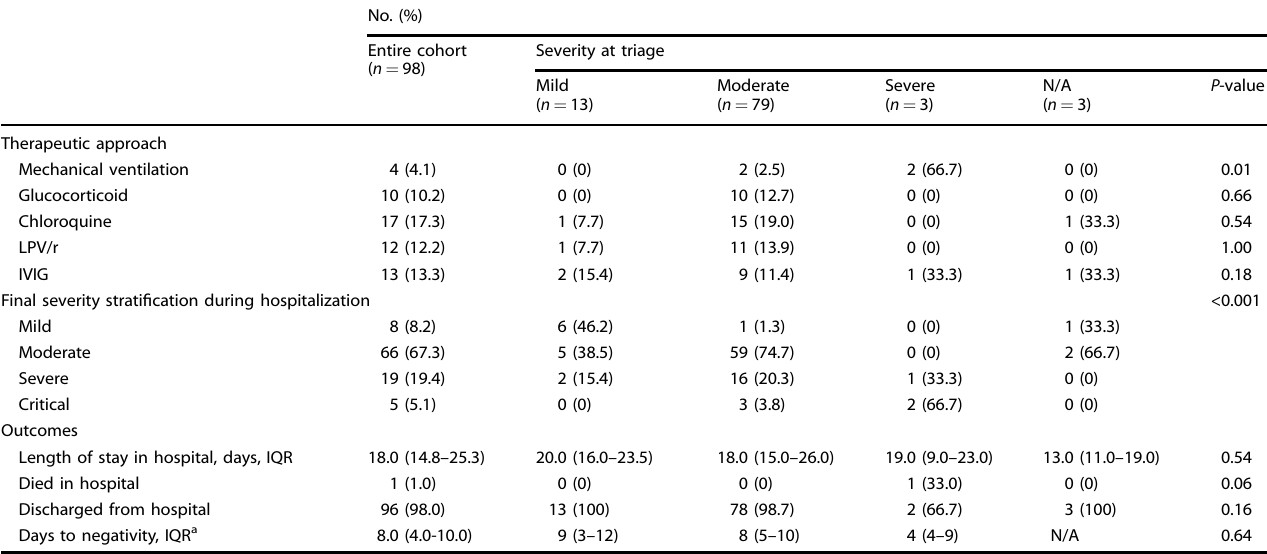
Table 2. Overview of therapeutic interventions and clinical outcomes for patients with COVID-19 by severity at triage.